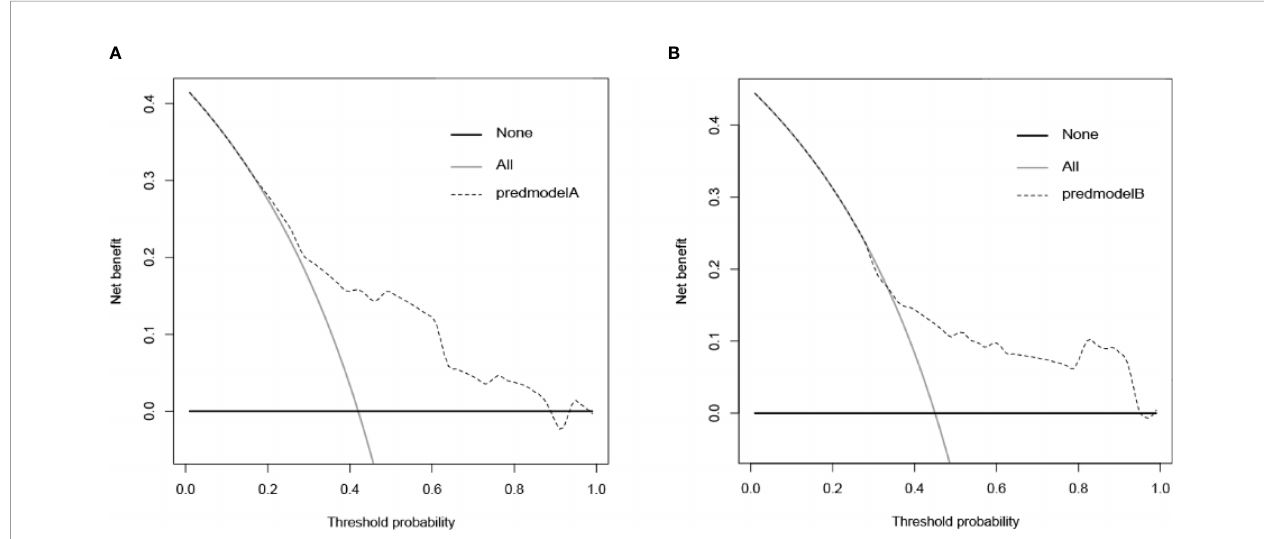
FIGURE 4 | Decision curve analysis (DCA) for the nomogram in (A) training data set and (B) external validation data set. The training data are concentrated between approximately 20% and 90% and the external validation data are approximately between 30% and 90% of the total